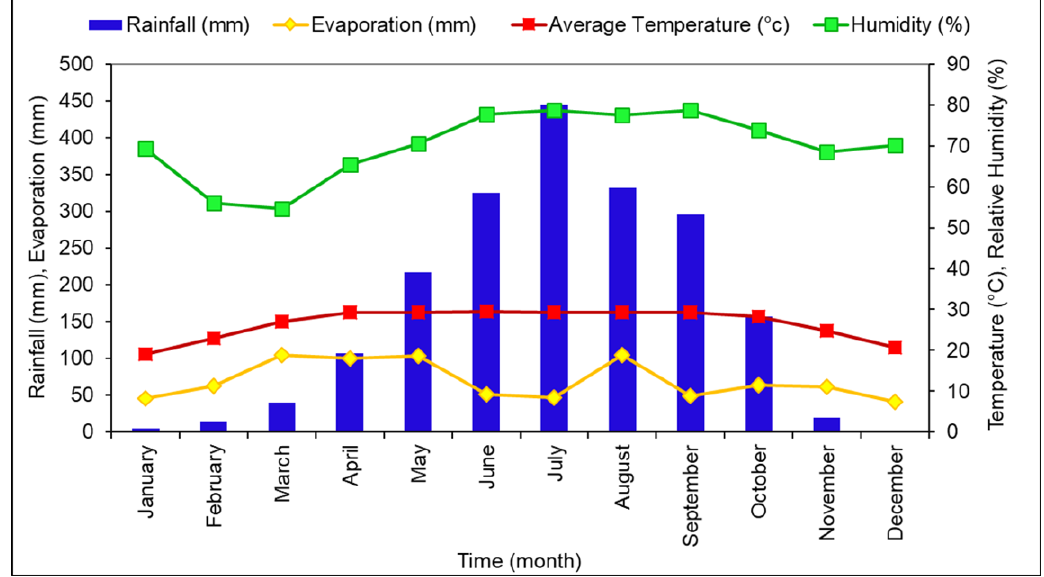
Figure 3. Long term (2005–2016) monthly average rainfall (mm), average temperature (°C), potential evaporation (mm) and relative humidity (%) in Dhaka city.